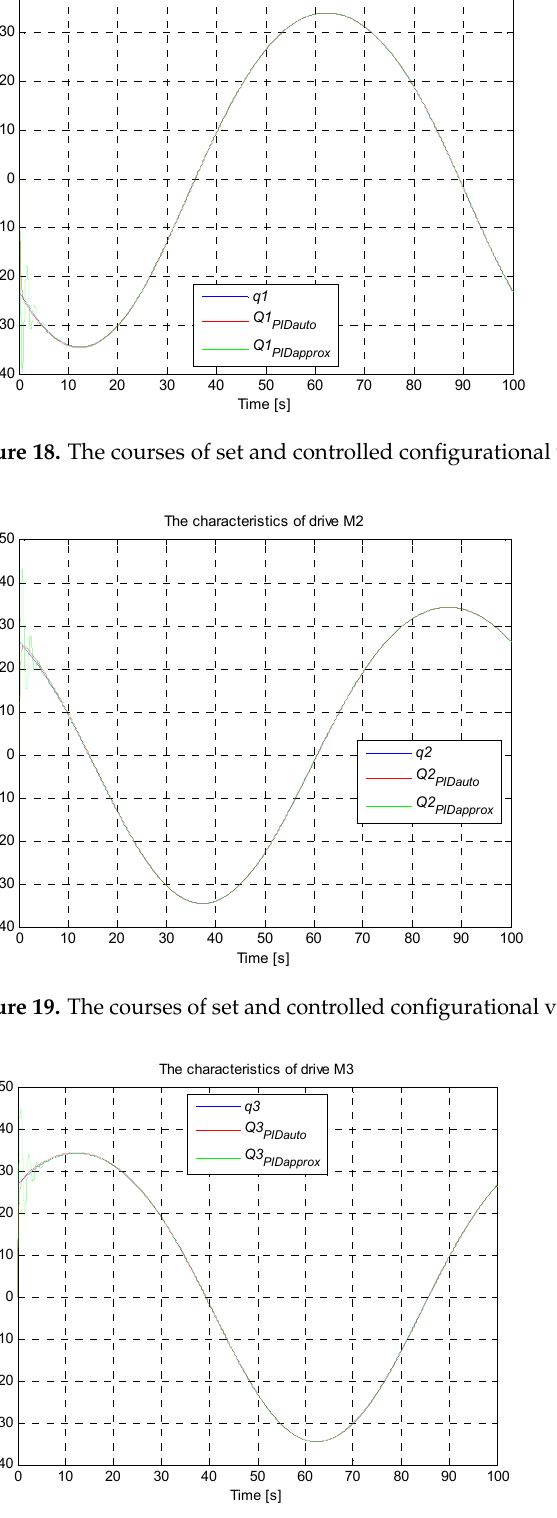
Figure 20. The courses of set and controlled configurational variables for the drive of the third arm.